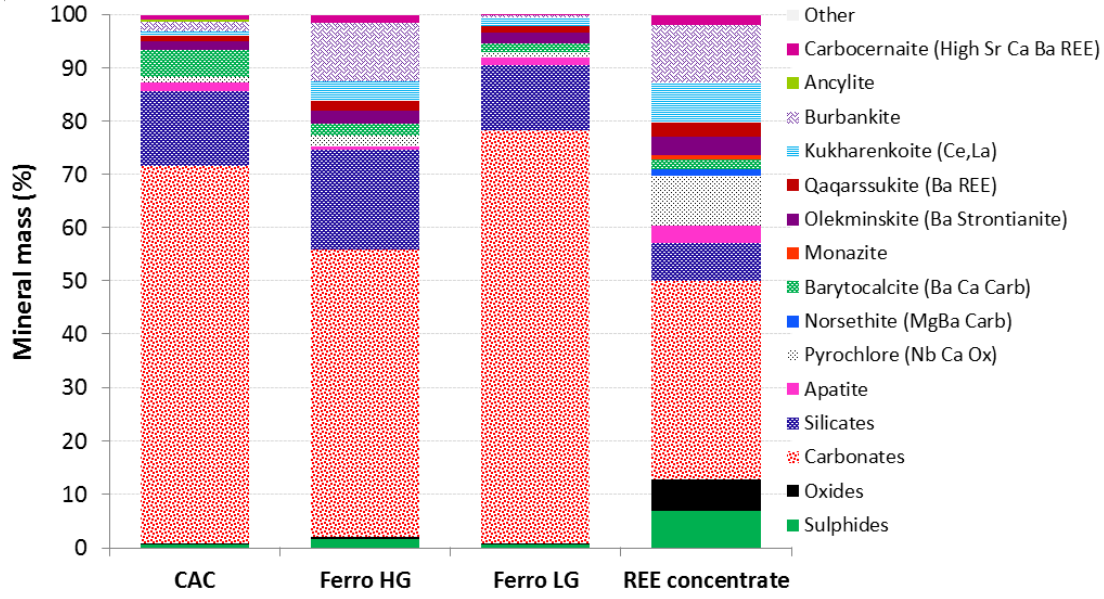
Figure 5. QEMSCAN assessment of Montviel lithologies and REE concentrate.